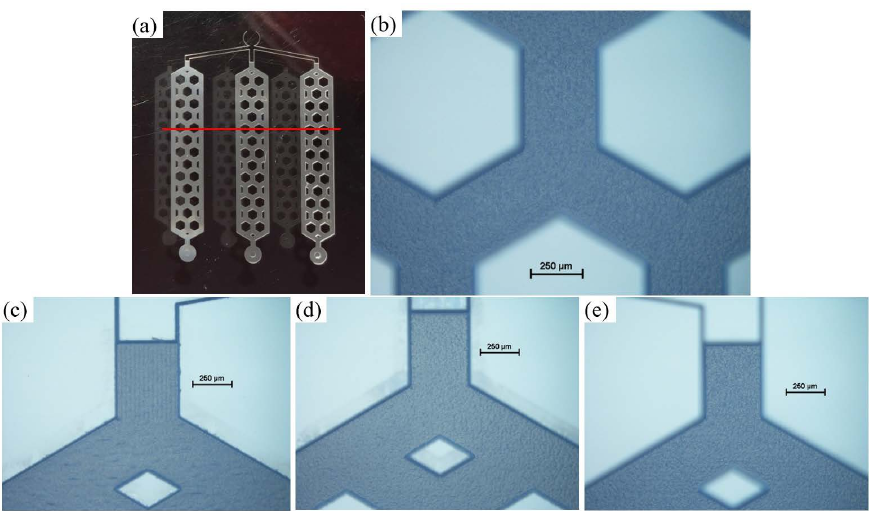
Figure 7. Images of several sections of the FLMP fabricated 3D multi-depth reservoir micromodel: ( a ) the red line illustrates the line profile scan path which goes through three pore spaces and two hexagonal pore bodies for each reservoir (R), ( b ) a zoom-in section of reservoir 3 where the image was focused at the etched surface, and ( c – e ) shows inlet portions of reservoirs 1, 2, and 3, respectively. Images ( b , e ) looks blurrier than ( c , d ) due to deeper depth as the microscope was focused on the bases of the channels. The scale bars are 250 µ